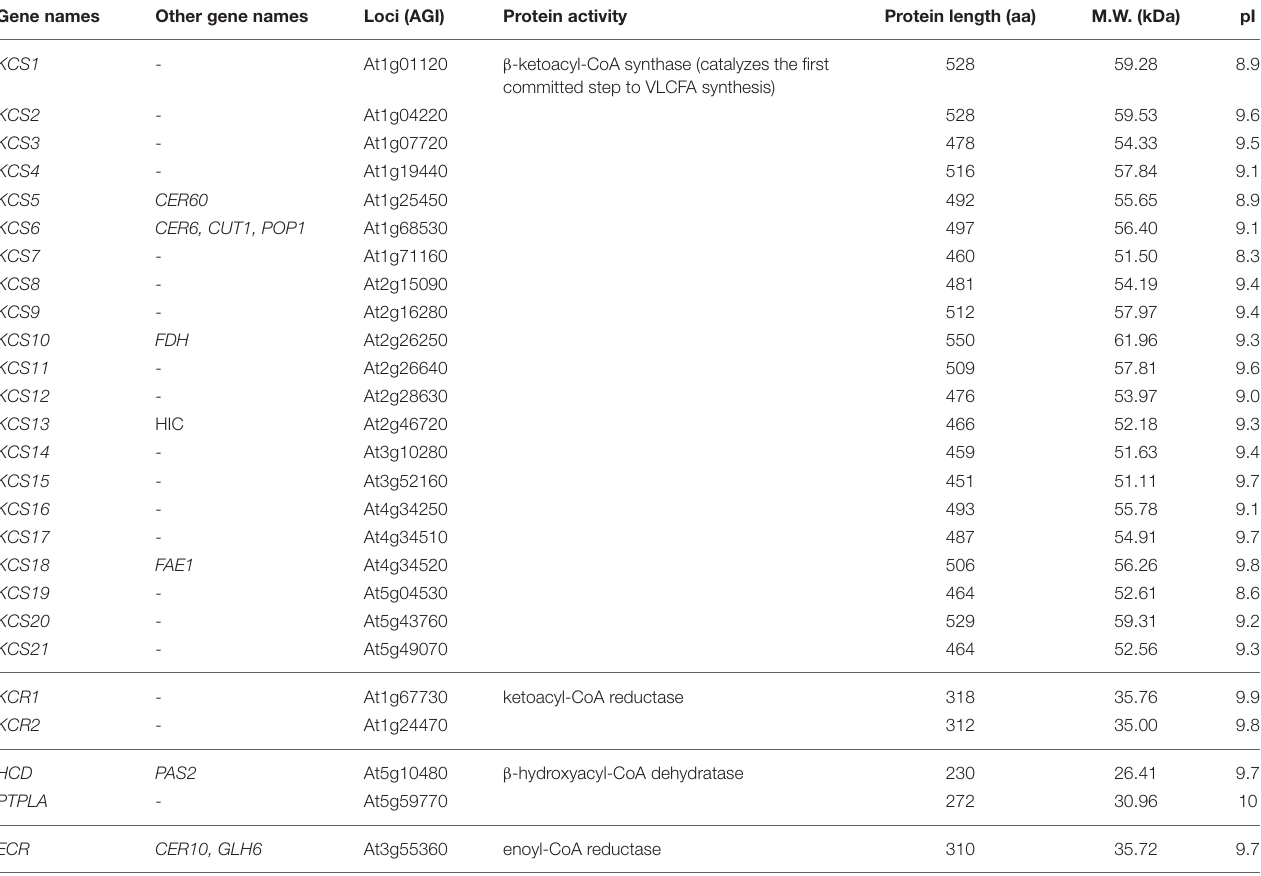
TABLE 1 | Nomenclature of the VLCFA elongase complex-encoding